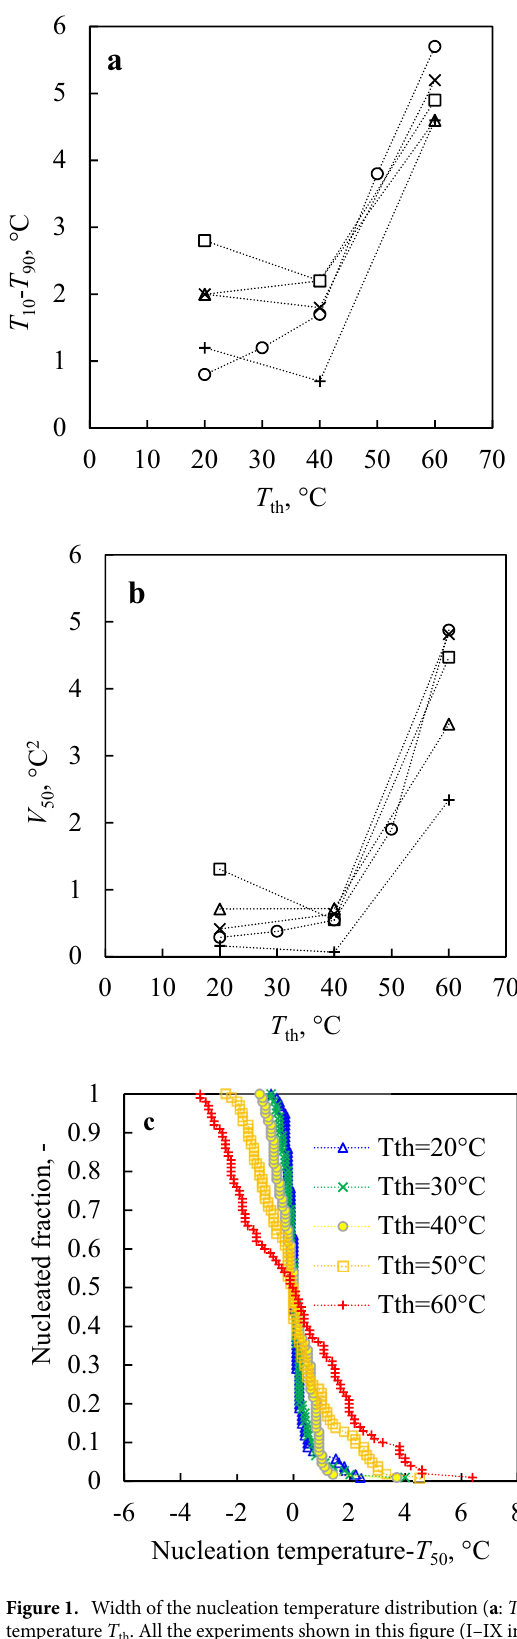
Figure 1. Width of the nucleation temperature distribution ( a : T 10 - T 90 , in °C, b : V 50 , in °C 2 ) versus the maximum thawing temperature T th . All the experiments shown in this figure (I–IX in Table 1) are characterized by τ = 9 min. The width of the T n distributions increases as T th increases from 20 to 60 °C. In ( a ) and ( b ): circles correspond to experiments I–V, triangles to experiment VI, squares to experiment VII, crosses to experiment VIII, and pluses to experiment IX. c : Nucleated fraction versus nucleation temperature translated by T 50 (experiments I–V in Table 1). As the maximum thawing temperature rises from 20 to 60 °C, the survival curves stretch over the horizontal axis, indicating a broader nucleation temperature